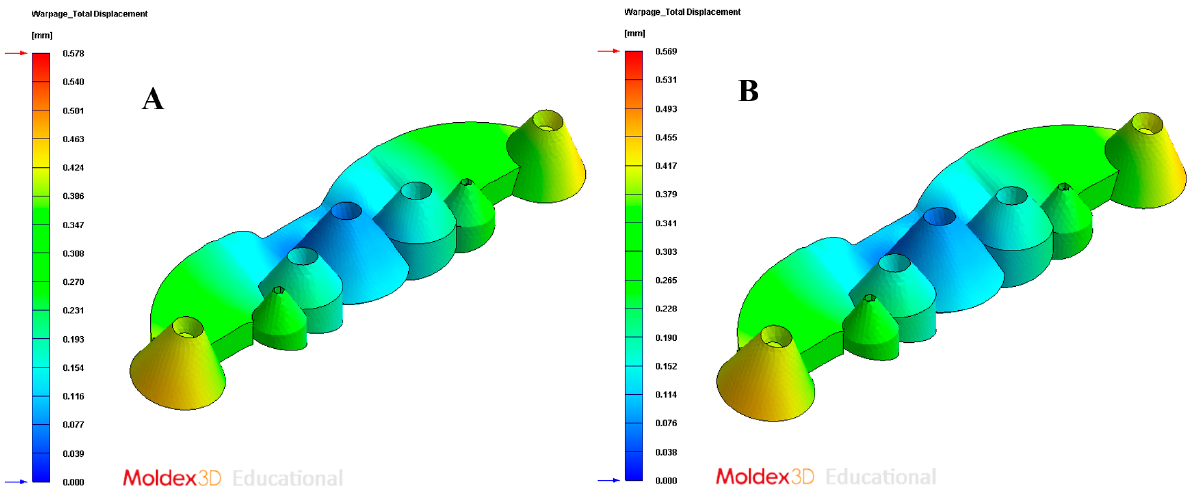
Figure 26. Total warpage displacements. ( A ) Traditional cooling; ( B ) conformal cooling.